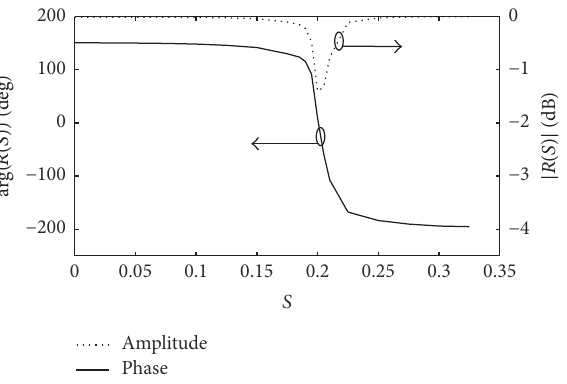
Figure 9: Simulated reflection coefficient versus 𝑆 ( 𝐿 = 7.86 mm, Δ𝑥 × Δ𝑦 = 0.6𝜆